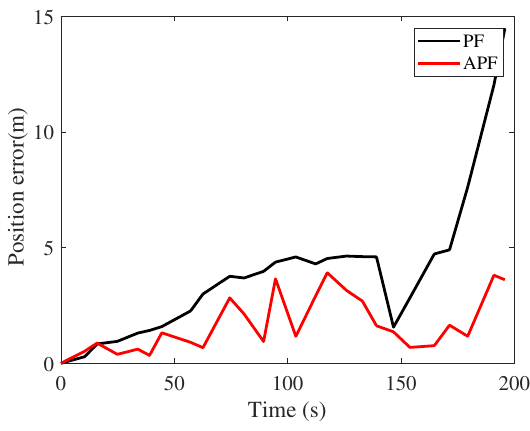
Figure 10. Position